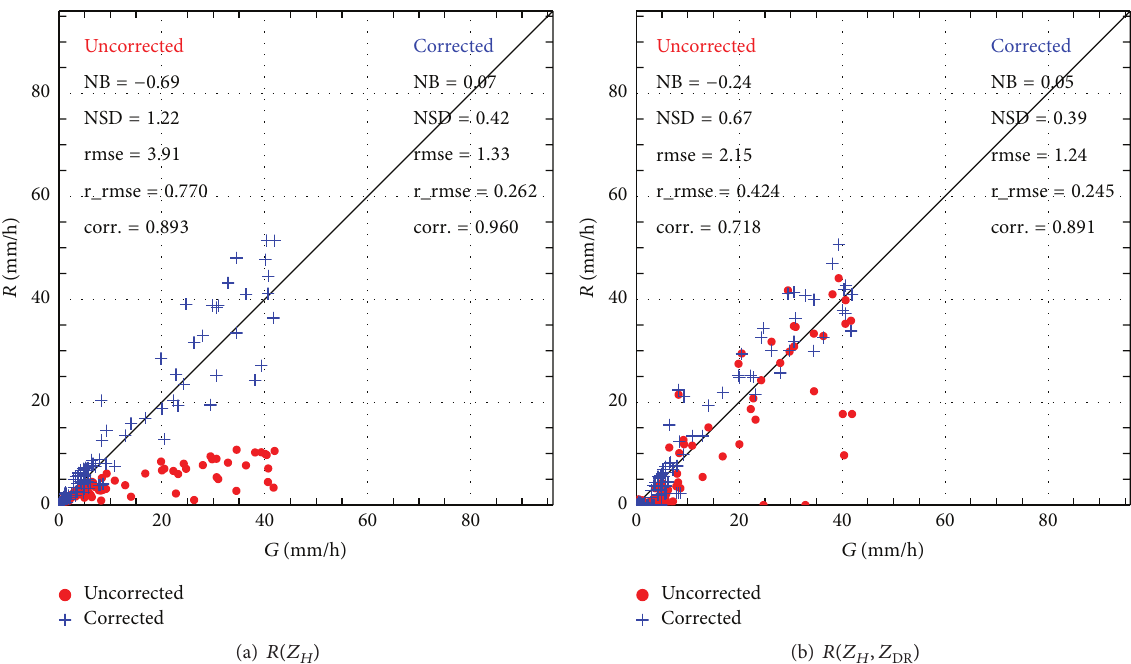
Figure 19: The scatter plots of 𝑅(6 km 2 , 10 min ) versus 𝐺(6 km 2 , 10 min ) (a) using 𝑍 𝐻 and (b) using 𝑍 𝐻 and 𝑍